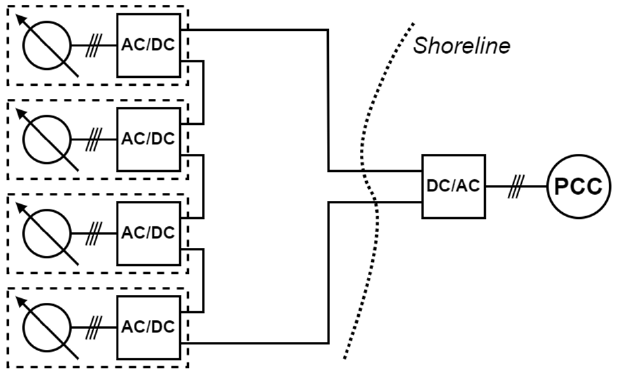
Figure 23. Topology T5. Series-connected DC collection grid with AC/DC conversion in the marine energy converters and no additional DC/DC step.